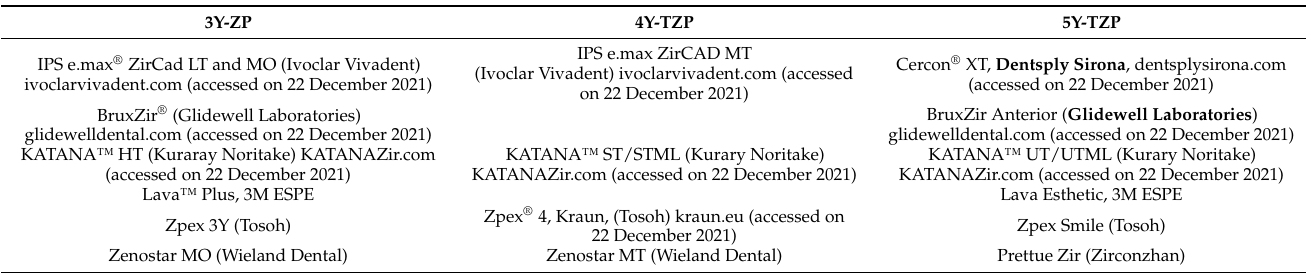
Table 1. Various types of dental Zir based on yttria